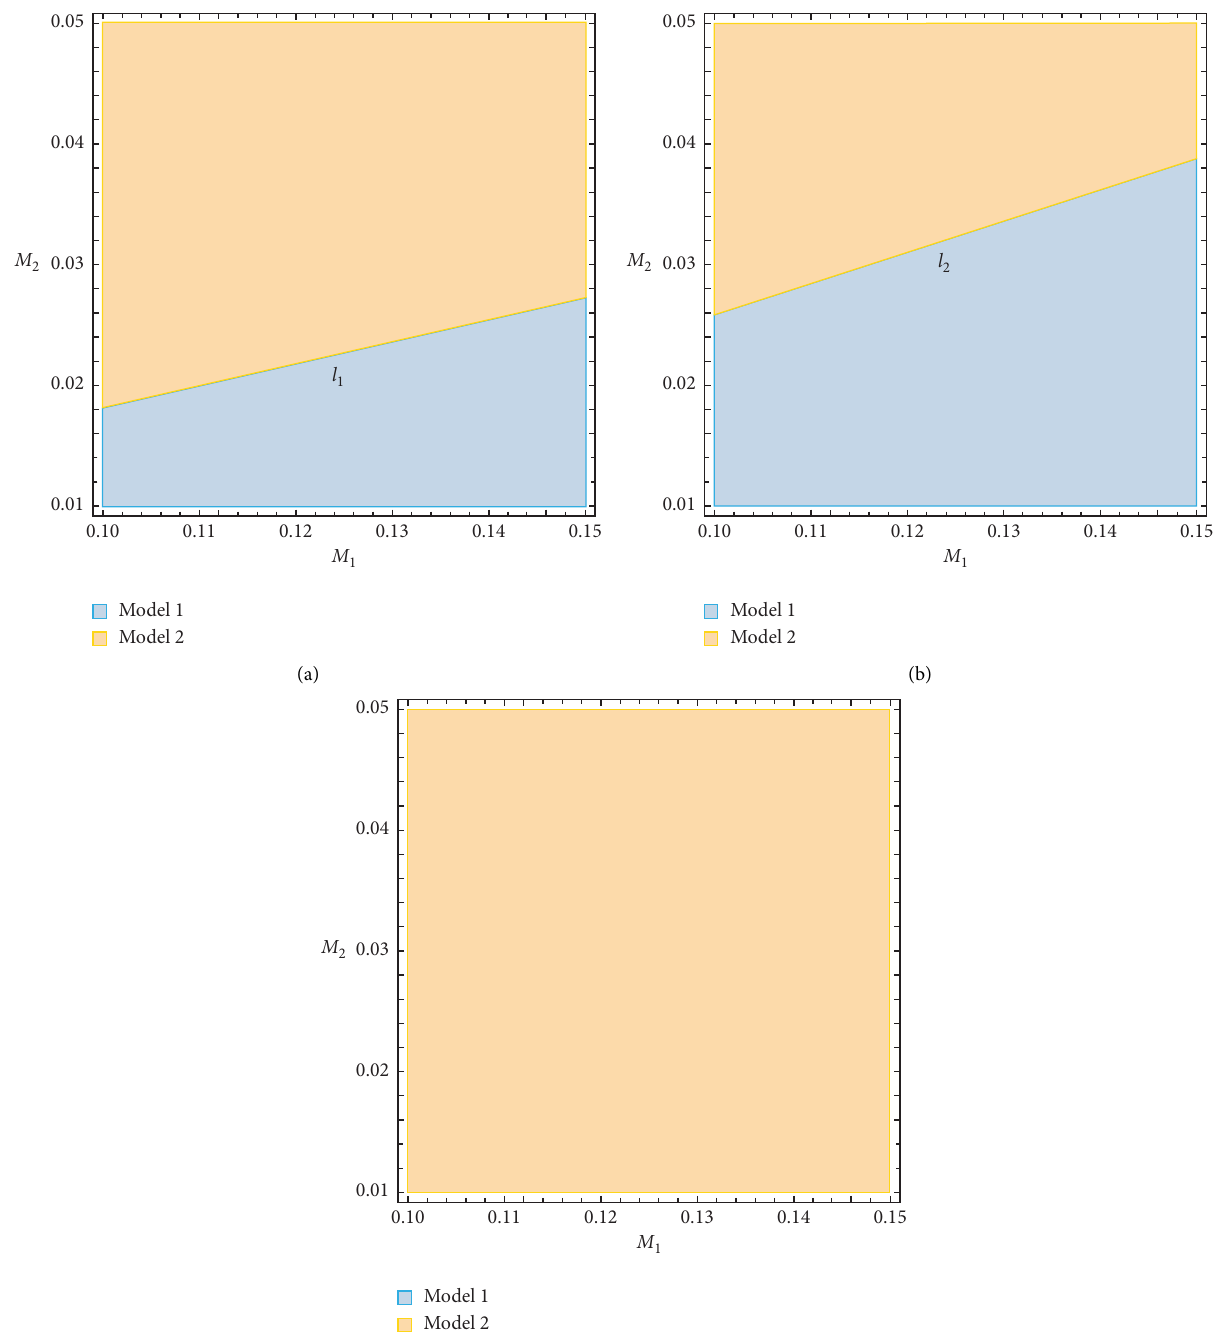
Figure 17: Selection of subsidy models with M (c)